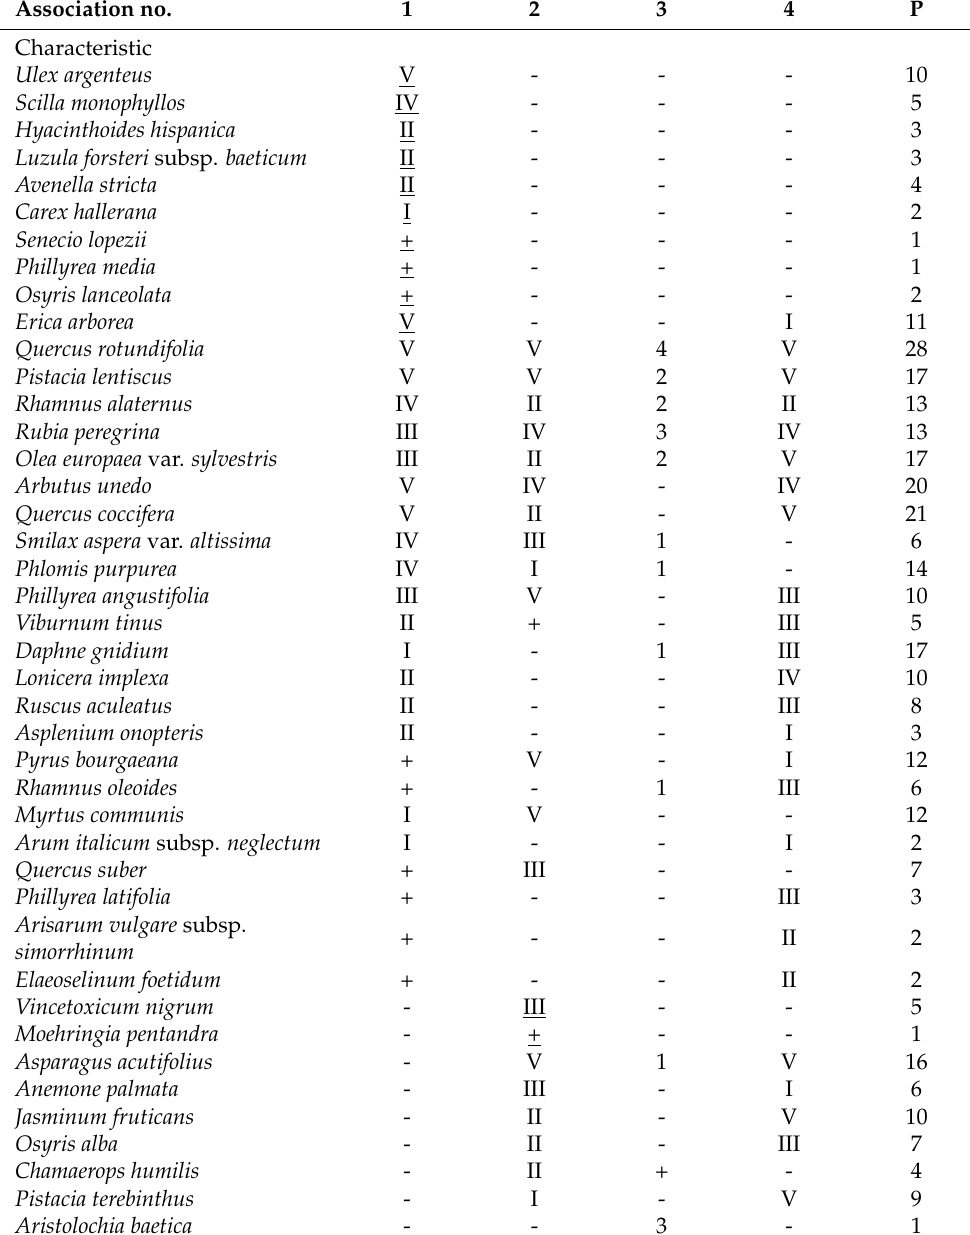
Table A1. Synoptic table of the holm oak woodlands linked to the Querco rotundifoliae-Oleenion sylvestris suballiance in the southwest of the Iberian Peninsula. Association